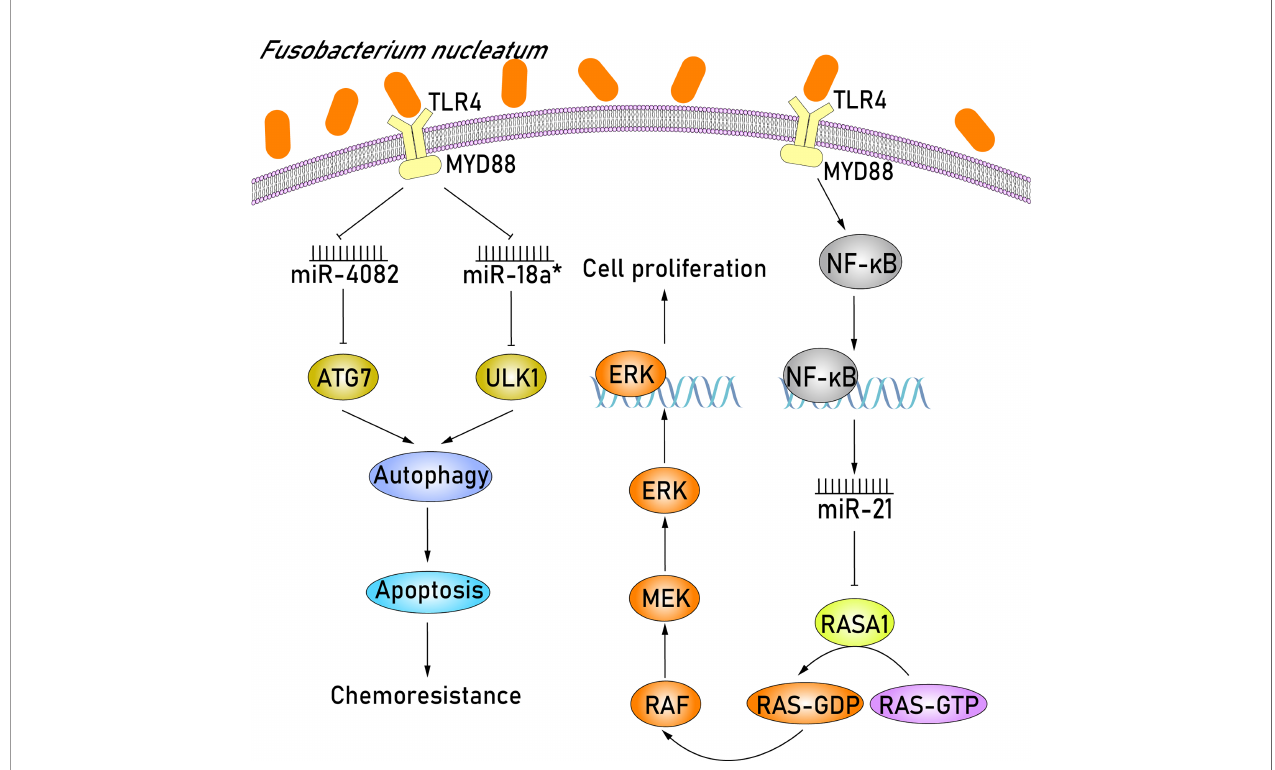
FIGURE 2 | F. nucleatum promotes cell proliferation by upregulating miR-21 and induces chemoresistance in CRC patients by downregulating miR-4802 and miR- 18a*. F. nucleatum initially recognizes TLR4/MYD88 signaling pathway and activates the key downstream effector NF- k B. NF- k B can bind to the promoter region of miR-21 and upregulate miR-21 expression, resulting in the subsequent downregulation of the downstream target gene RASA1. The partial functional loss of RASA1 can activate the GTPase activity of RAS, triggering the RAS-RAF-MEK-ERK (RAS-MAPK) signaling pathway. MAPK signaling pathway plays an important part in increasing cell proliferation, eventually leading to tumorigenesis. Furthermore, in the F. nucleatum – mediated chemoresistance of CRC cells, miR-4802 and miR-18a*, which are both dependent on the TLR4 and MYD88 signaling pathways, are signi fi cantly downregulated. The selective loss of miR-4802 and miR-18a* induces the upregulation of ATG7 and ULK1, respectively, which are members of autophagy signaling elements. Therefore, when these F. nucleatum – infected CRC cells are treated with chemotherapy agents, the autophagy pathway will be activated and consequently promote chemoresistance via suppressing cell